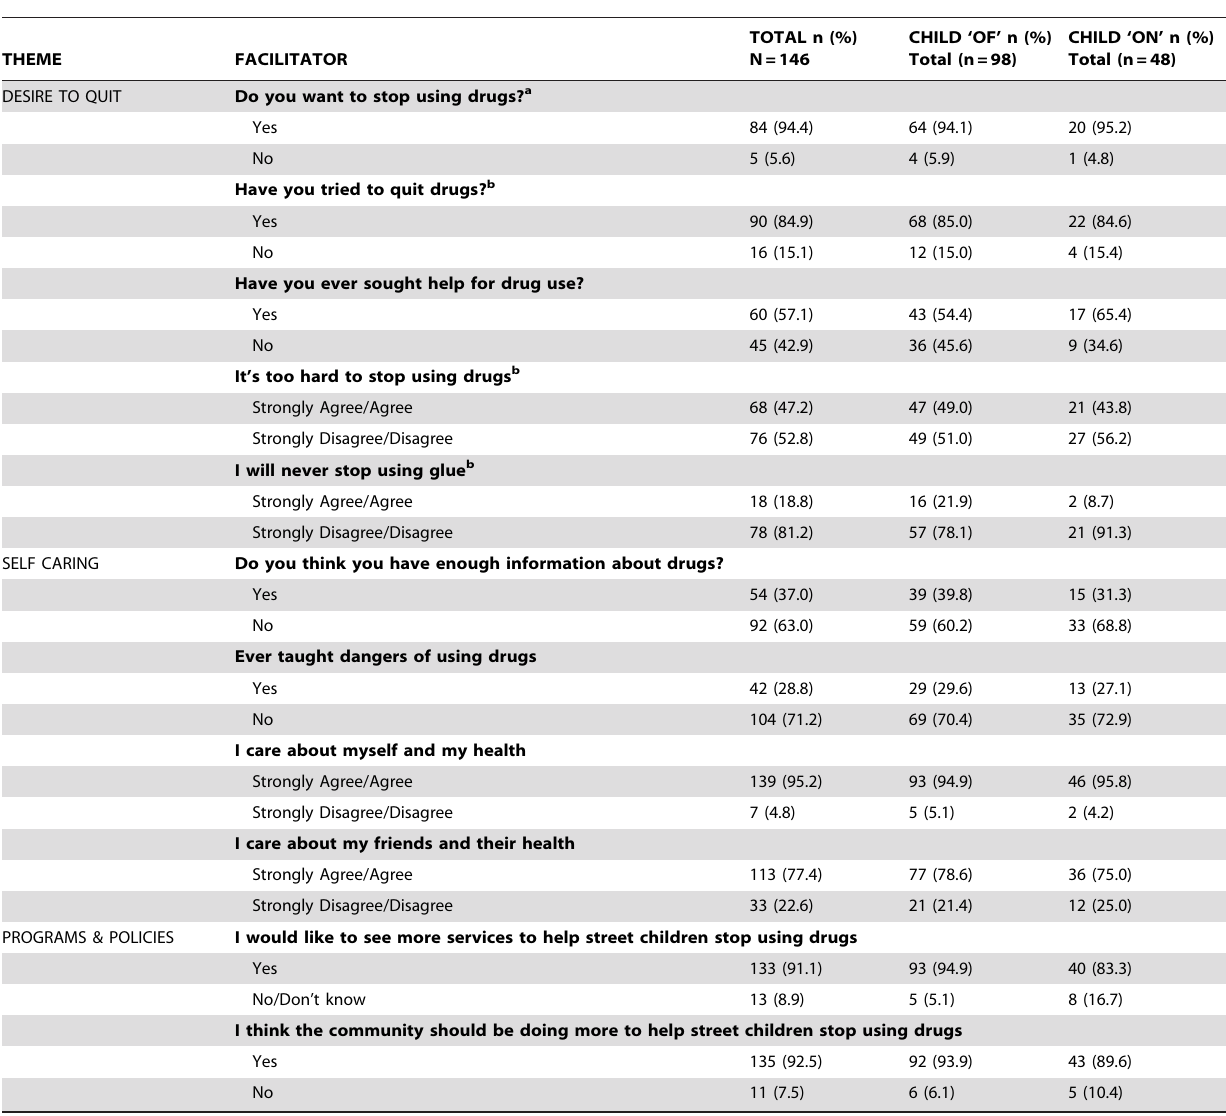
Table 3. Facilitators of drug cessation among 146 street-involved children and youth in Eldoret, Kenya.